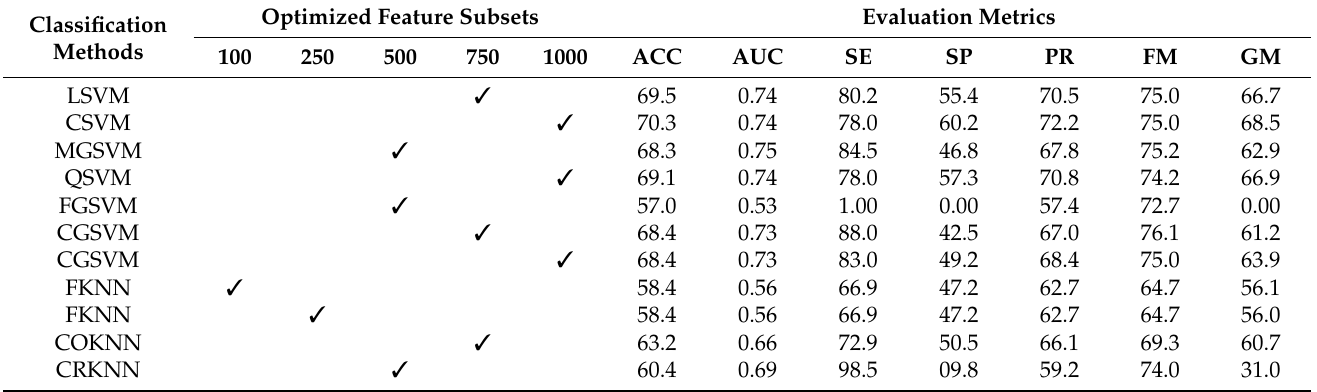
Figure 12. The best ROC outcomes on VIPeR dataset are presented in Figure 13. Table 11. Mixed view-based experimental results on VIPeR